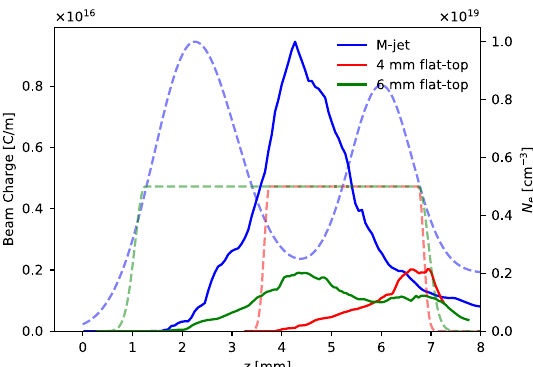
Figure 5. Comparison of the charge for the different jets. The simulation results of the charge near the laser propagation axis ( − 15 < k p y < 15 ) with a beam energy of γ > 20 is plotted as a function of the laser propagation distance z (solid line, left axis) for the density profiles (dashed line, right axis) for the M-jet (blue), the 4 mm flat-top (red) and the 6 mm flat-top